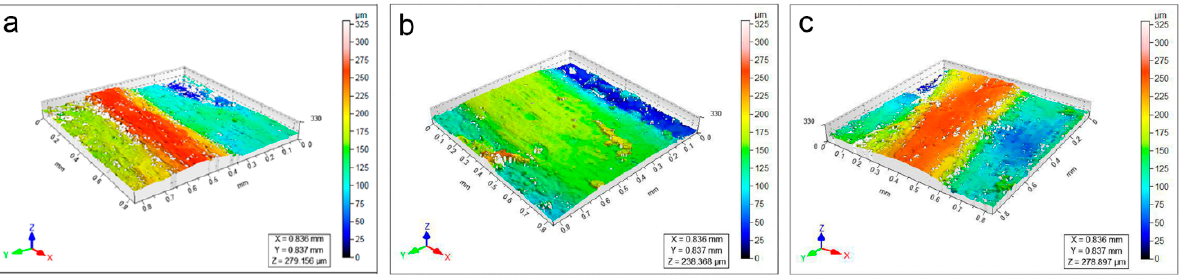
Figure 7. 3D heat maps of soiled-EAM ( a ) cleaned by CA_3 ( b ) and KGB_3 ( c ). The colour range represents the different heights (in microns) of the details present on the sample surface.